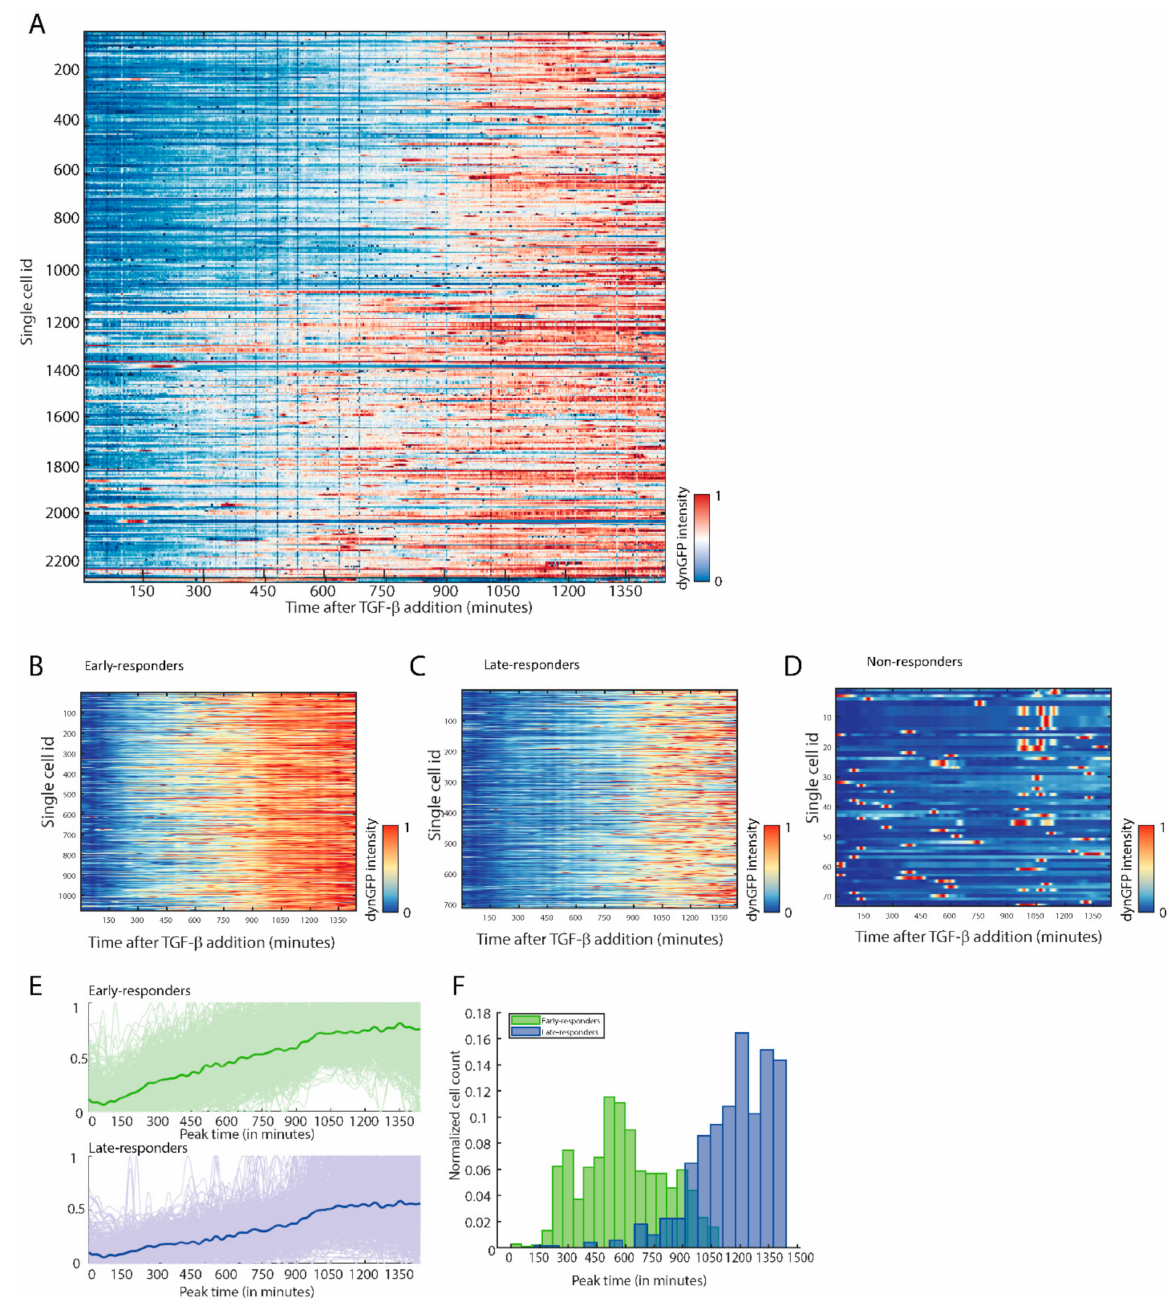
Figure 3. The TGF- β /SMAD3 dynGFP reporter can be used to identify heterogenous TGF- β /SMAD3 responses on a single cell level. ( A ) Heatmap showing the increase of relative dynGFP intensity between 0 (blue) and 1 (red) of live cell imaging for 24 h of individual B16F10 melanoma cells stably expressing CAGA 12 -dynGFP (Clone 7 population). Cells were stimulated with TGF- β 1 (1 ng/mL) during the 24 h of imaging. ( B – D ) The dynamic TGF- β /SMAD3 dynGFP response in B16F10 cells can be divided into three distinct clusters: early responders ( B ), late responders ( C ), and non-responders ( D ). ( E ) Early TGF- β /SMAD3 dynGFP responders show an increase and plateau in dynGFP signal earlier after TGF- β stimulation compared to late responders. ( F ) Histogram plot reveals that the timing of the peak in dynGFP signal after TGF- β stimulation differs between early and late